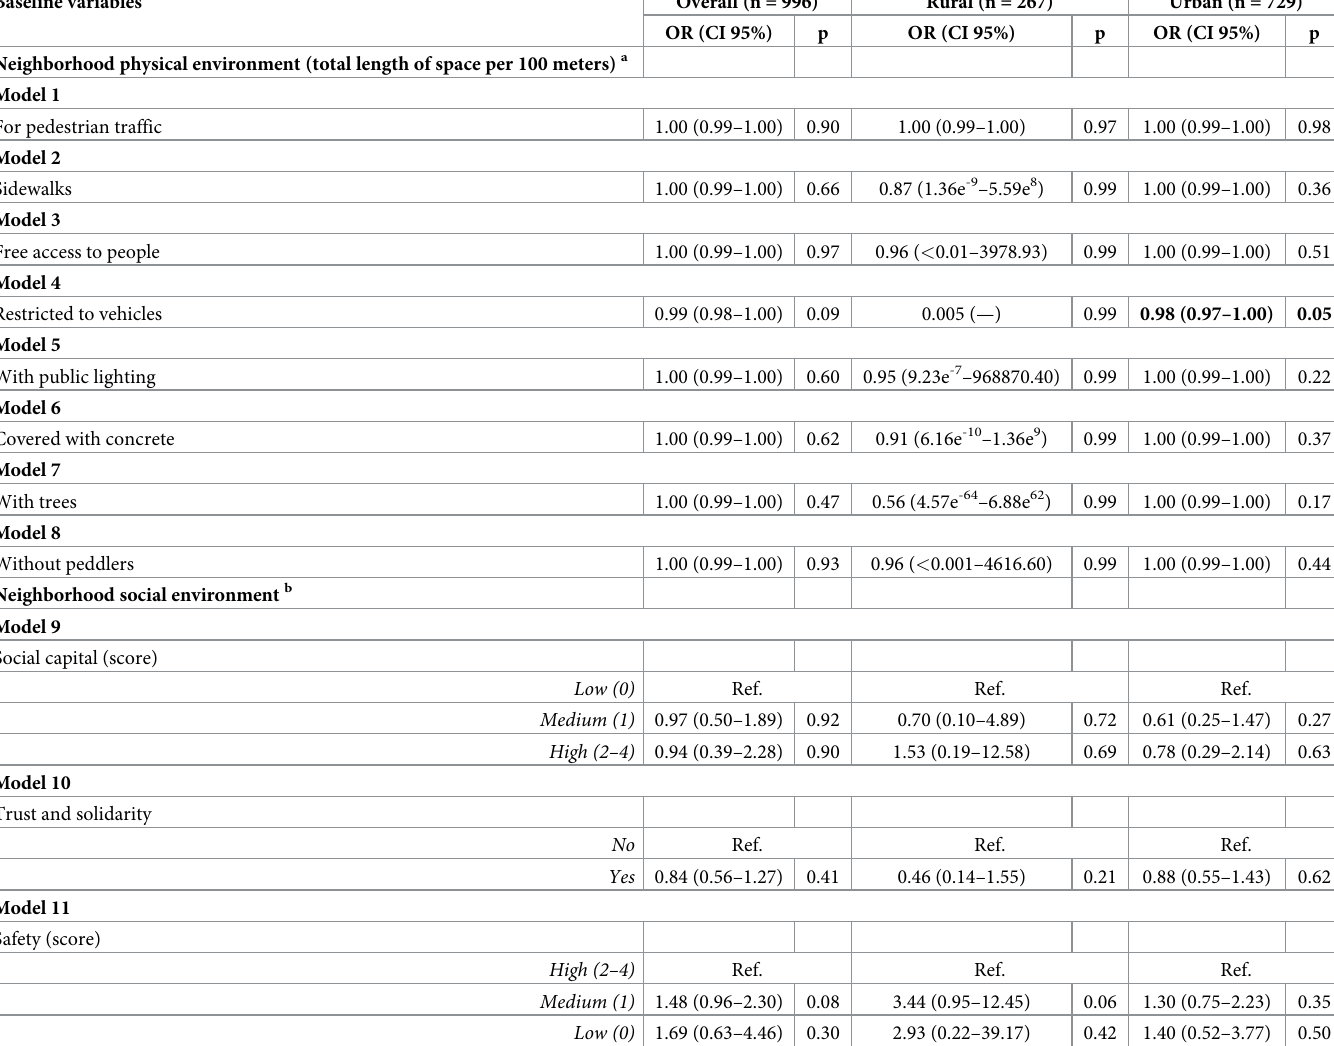
Table 2. Association between the neighborhood physical and social environment and the incidence of depression in Mexican older adults from SAGE Waves 1 and 2, 2009–2014. Baseline